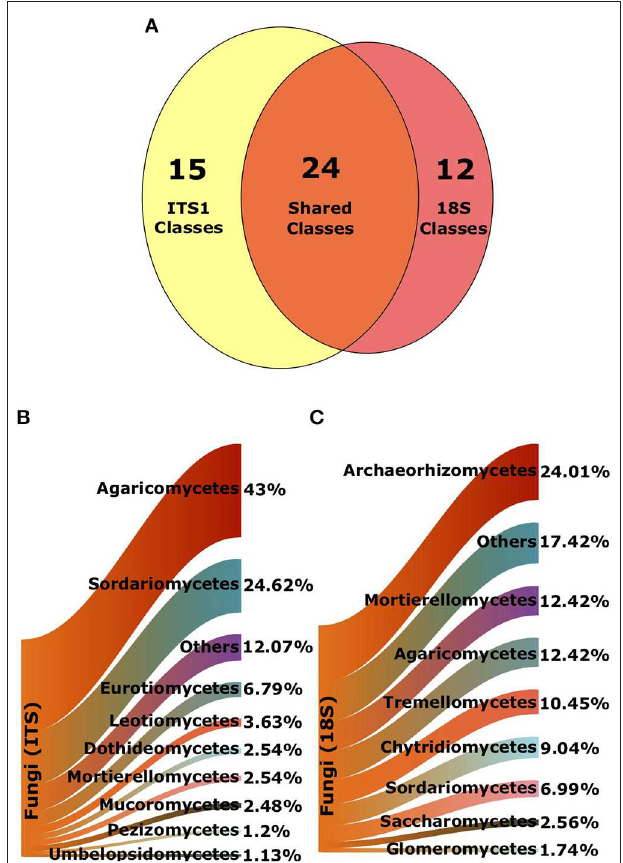
FIGURE 2 | Composition of fungal classes from ITS1 and 18S datasets. (A) Venn diagram denoting total number of shared and unique classes in each data set, following exclusion of unknown sequences. Sankey diagrams of proportional abundances of fungal OTUs from all samples from (B) ITS1 data and (C) 18S data. Arms denote proportions of OTUs of the most populous